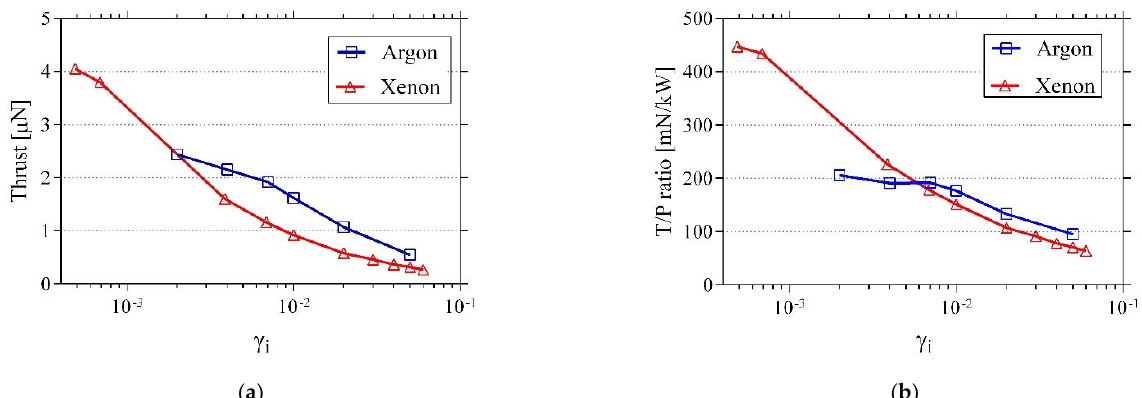
Figure 5. Influence of the secondary electron emission coefficient in the thruster’s performance in the thruster’s performance: ( a ) variation of the output thrust T in ( μ N) for several γ i ; ( b ) variation of the thrust-to-power ratio T / P in (mN/kW) for several γ i.